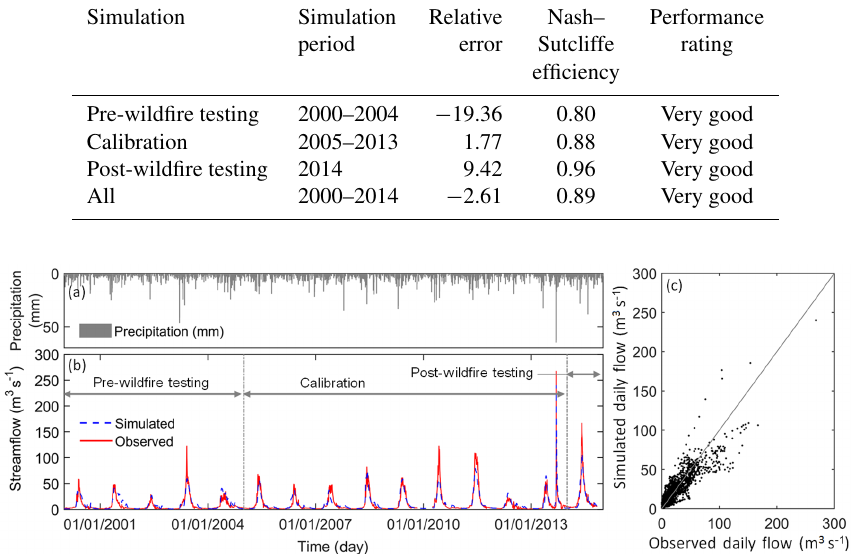
Figure 4. (a) Total daily precipitation during simulation period. (b) Observed versus simulated average daily streamflow hydrographs. (c) Observed versus simulated average daily streamflows scatter plot.